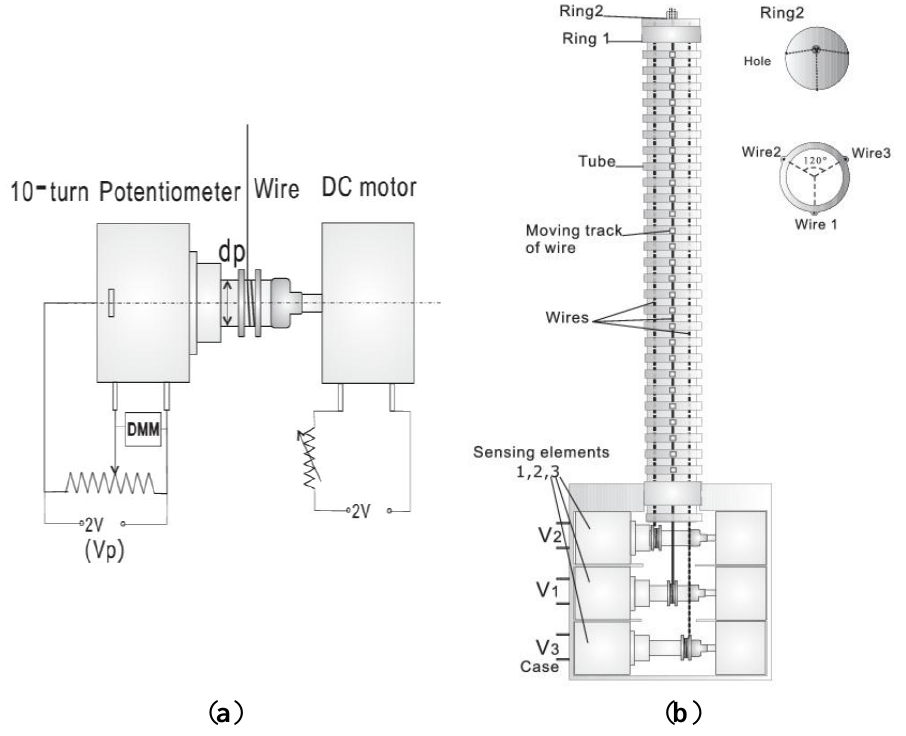
Figure 4. Configuration of the prototype. ( a ) Sensing element; ( b ) Structure of the